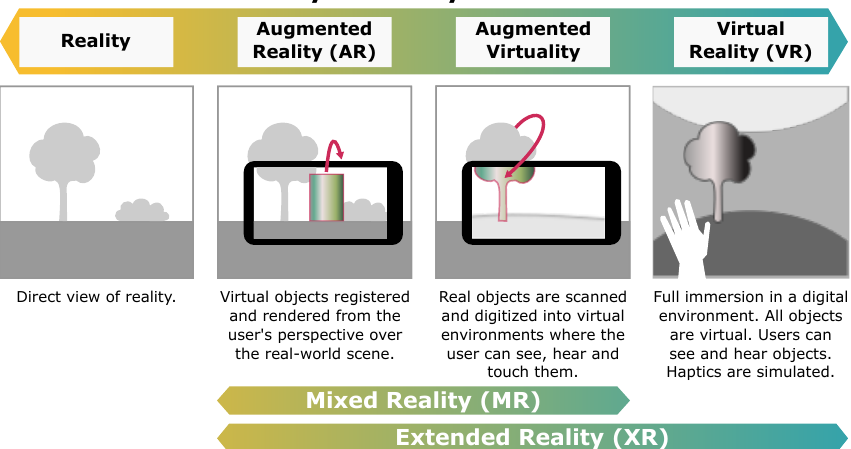
Figure 1. Reality–virtuality continuum. Spectrum of physical and extended reality, with virtual reality at one end and the real world at the